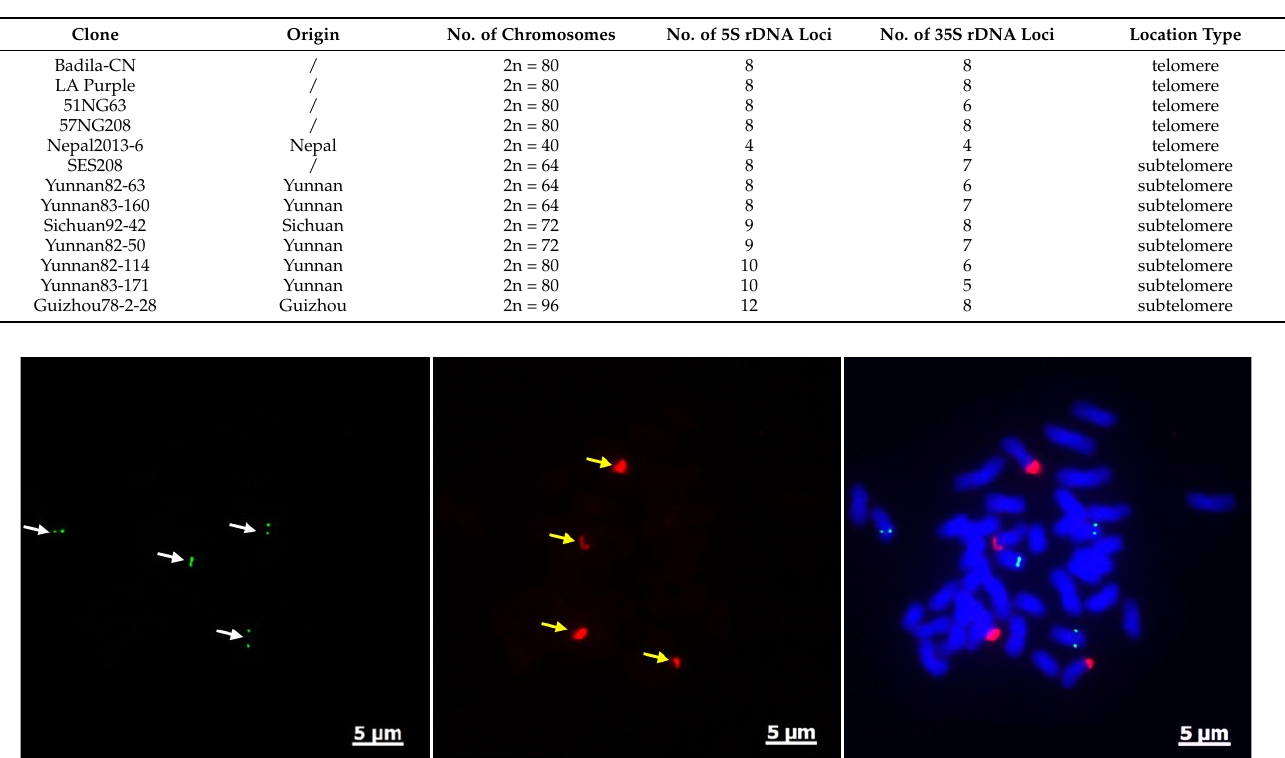
Table 2. The 5S and 35 rDNA loci in S. officinarum , S. robustum , and S. spontaneum .